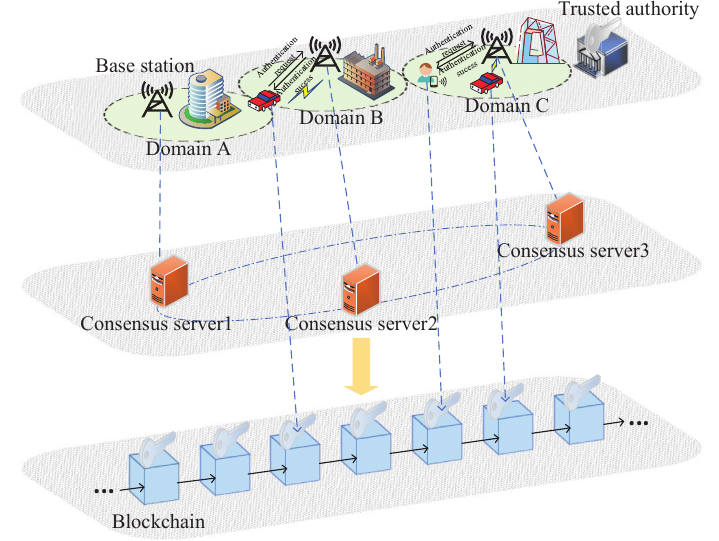
Figure 11. Cross-Domain Anonymous Authentication System